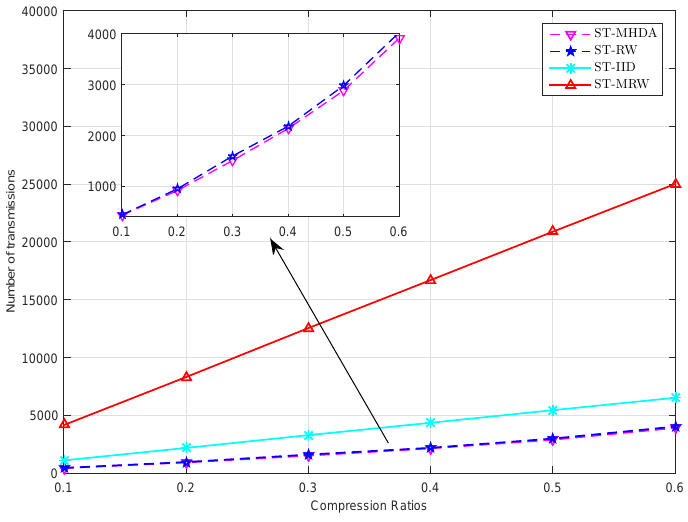
Figure 7. The number of transmissions required for different CS-based